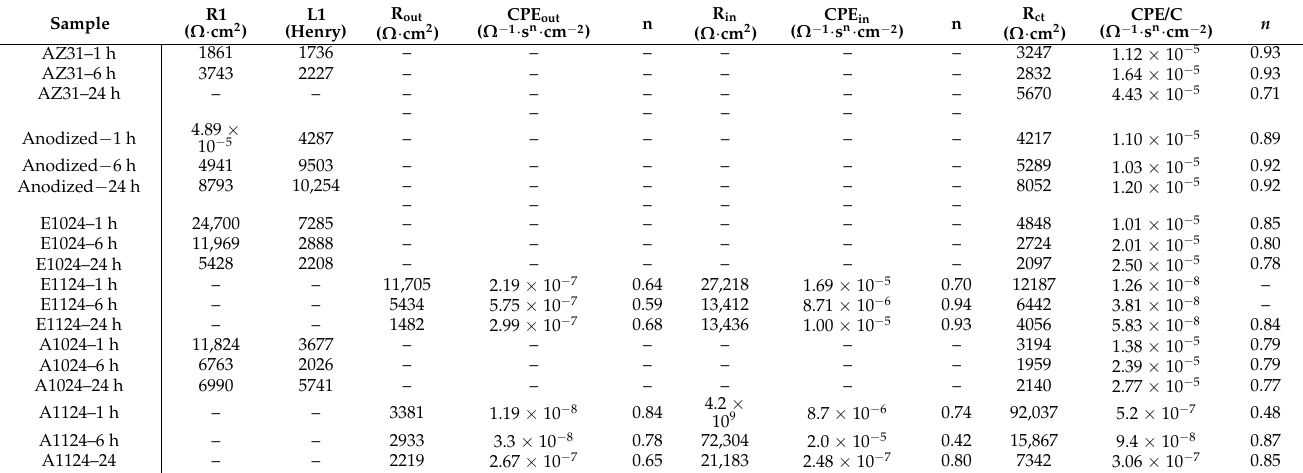
Figure 13. Equivalent circuits used for fitting the electrochemical impedance diagrams. Table 6. Results of fitted EIS diagrams for the etched and anodized substrates and LDH films at different immersion